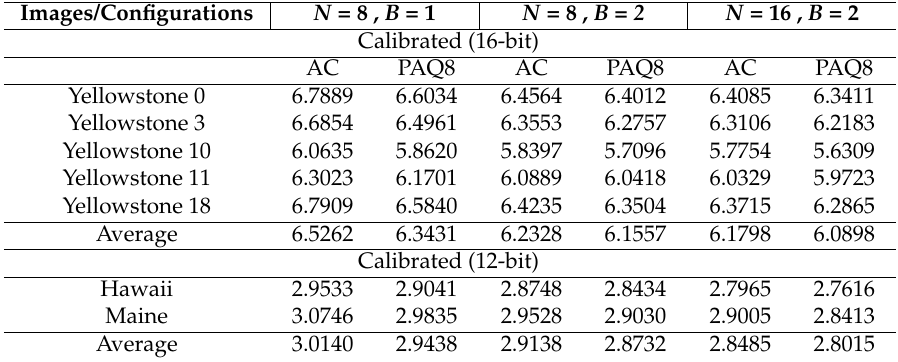
Table 13. Achieved results for the uncalibrated images of the CCSDS dataset.